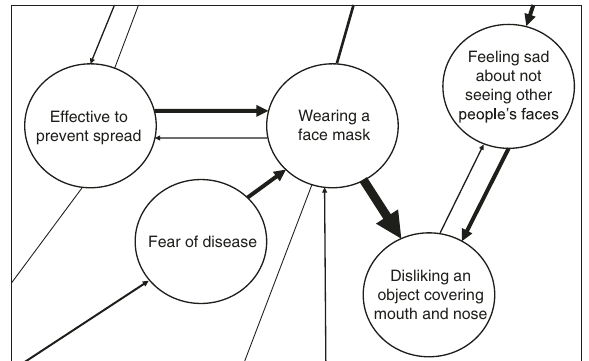
Fig. 1 Hypothetical, simpli fi ed network of the attitude toward wearing a face mask. The network consists of a behavioral element ( “ Wearing a face mask ” ), cognitive element ( “ Wearing a face mask is effective to prevent the spread of the virus ” ), and three affective elements ( “ Fear of disease caused by the virus ” , “ Feeling sad about not seeing other people ’ s faces ” and “ Disliking an object covering mouth and nodes ” ). Edges with arrows indicate the direction of predictive effects and the width indicates the strength of this effect. This example shows that disliking an object covering mouth and nose is predicted by both wearing a face mask and feeling sad about not seeing other people's faces, with the former having the strongest predictive effect, as indicated by different edge width. The example shows both unidirectional (e.g., wearing a face mask and fear of disease) and bidirectional effects (e.g., wearing a face mask and effective to prevent spread) with edges of different strengths.